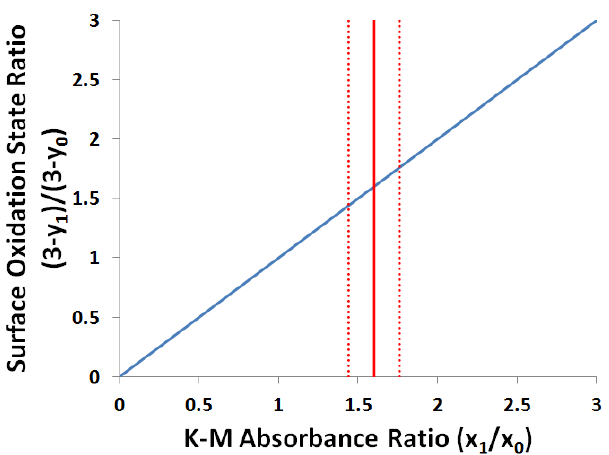
Figure 14. The ratio of surface Fe oxidation states in 1La to the oxidation state in 0La as a function of the ratio of the normalized absorbance. The figure shows the 95% upper and lower bounds of the regression.